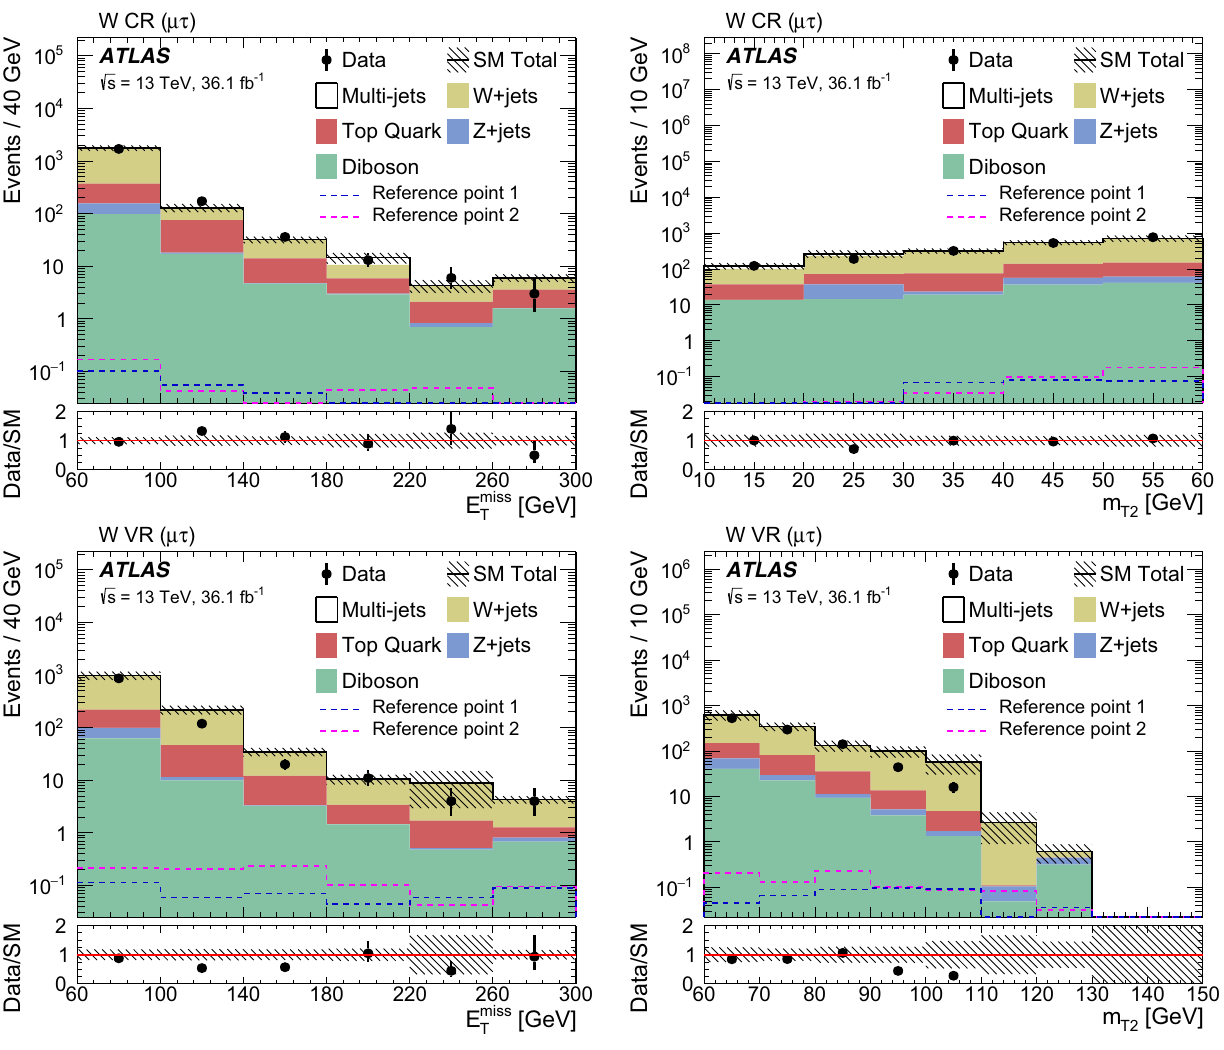
Fig. 4 The E miss T (left) and m T2 (right) distributions in the W -CR (top) and W -VR (bottom) regions. The SM backgrounds other than multi-jet production are estimated from MC simulation. The contribution of W + jets events is scaled to the fit result. The multi-jet contribution is esti- mated from data using the OS–SS method. The hatched bands represent